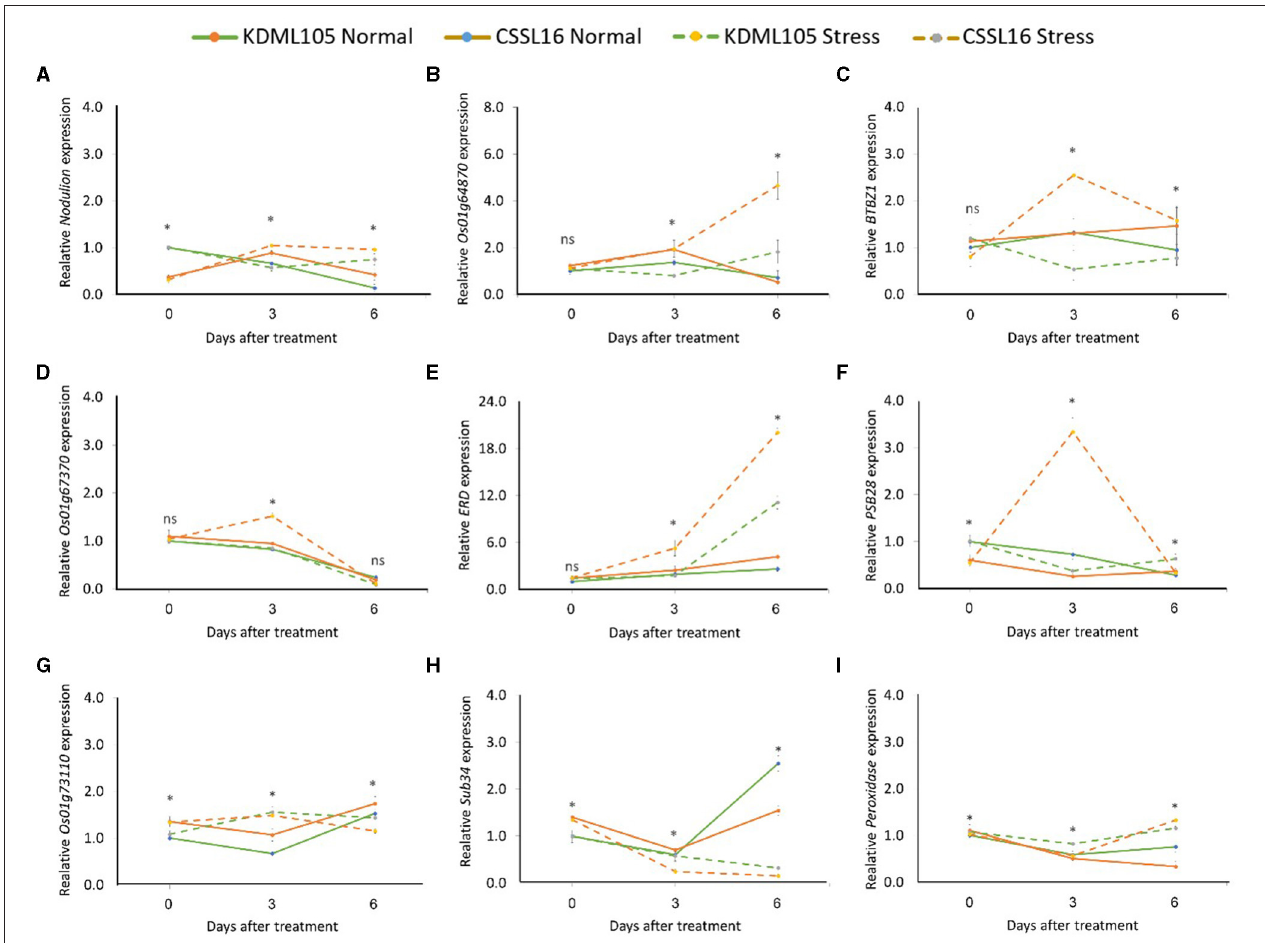
FIGURE 10 | Gene expression analysis of nine candidate genes, Nodulin (A) , Os01g64870 (B) , BTBZ1 (C) , Os01g67370 (D) , ERD (E) , PSBS28 (F) , Os01g73110 (G) , Sub34 (H) , and Peroxidase (I) in CSSL16 and KDML105 under normal and salt stress conditions at day 0, 3, and 6 of salt stress. *indicates the significant difference among mean of the gene expression at p <